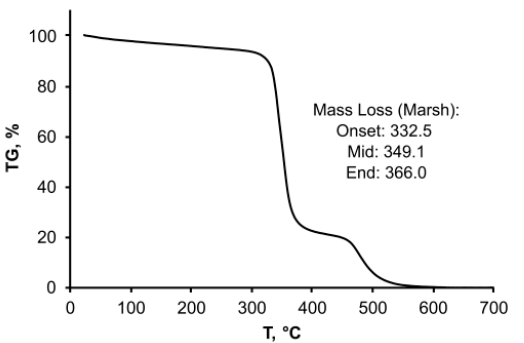
Figure 6. TGA curve of OSTE-MS polymer in air. Heating rate 1 ◦